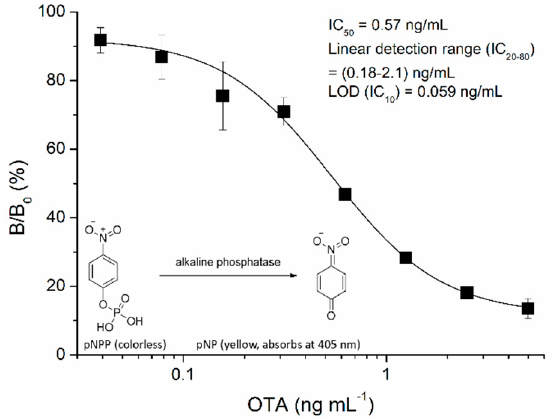
Figure 4. Standard direct competitive inhibition curve of Nb-AP-based one-step ELSIA for OTA under the optimized conditions. The error bars represent the standard deviation of five independent tests.